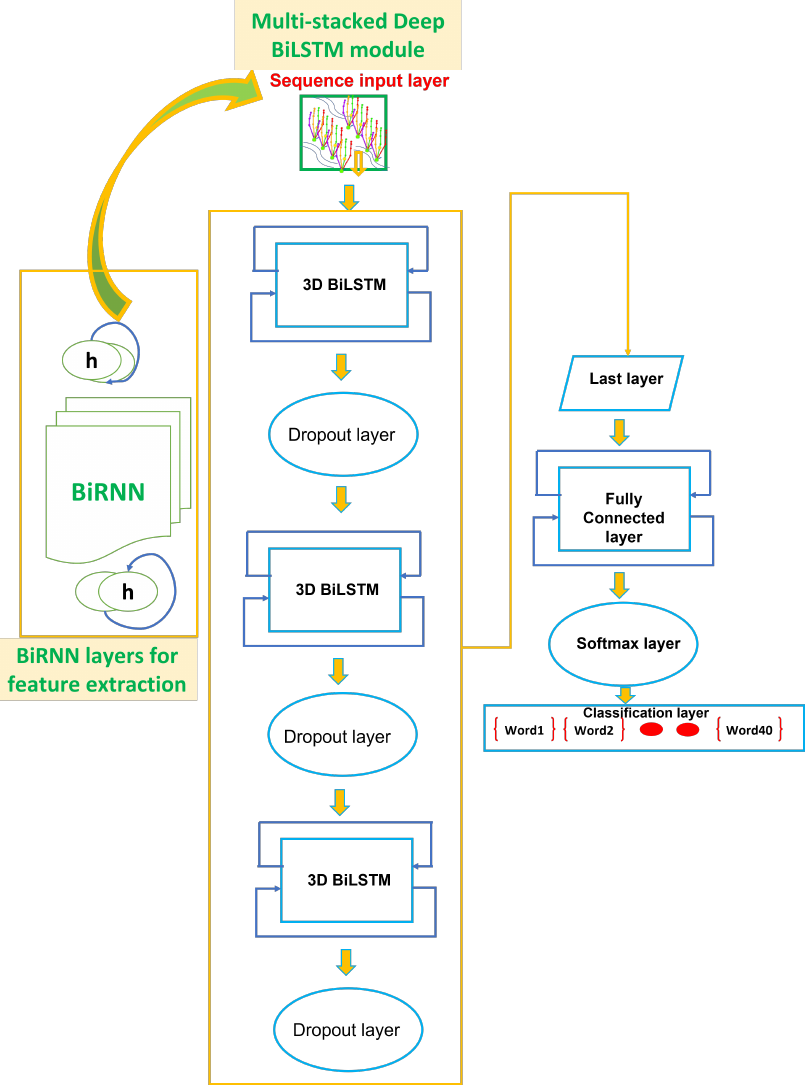
Figure 5. Proposed Architecture of Multi-stack Deep